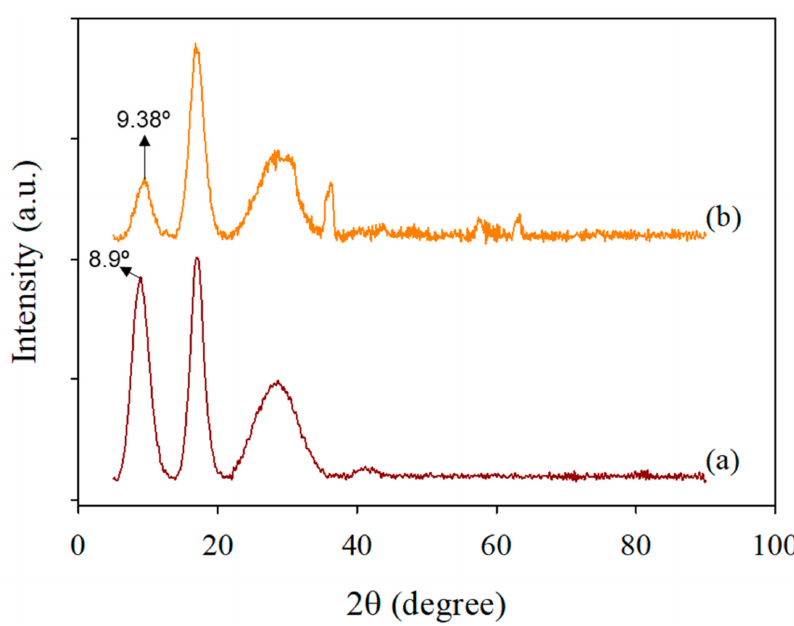
Figure 10. XRD results of composite nanofiber membranes after adsorption: ( a ) PEI-AN, and ( b ) Fe/PEI-AN.